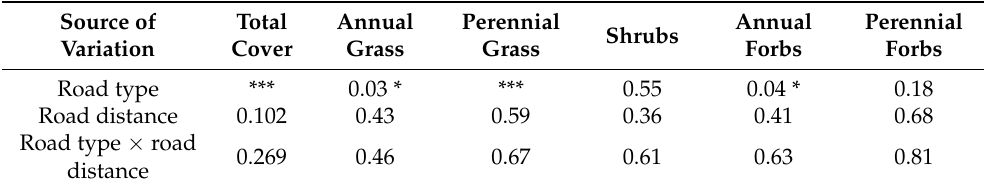
Table 4. Effects of road types, distances from the roads and their interaction (results of two-factor ANOVA) on the total canopy cover and functional group cover.